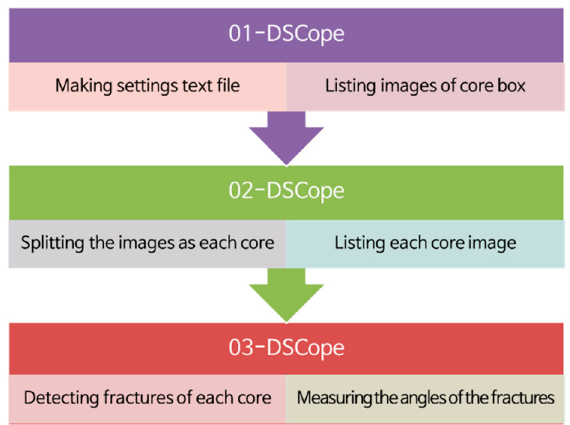
Figure 1. Flow chart of the DSCope